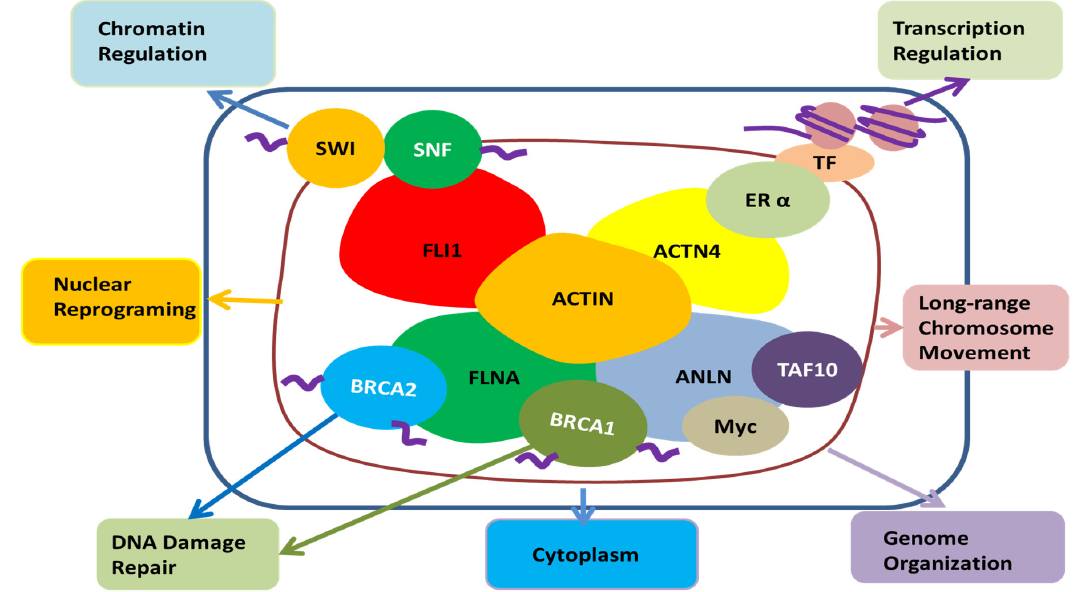
Figure 4. The potential role of ANLN in the nucleus; Actin present in the nucleus is combined with FLi1 homolog, α -actinin 4, filamin A, SWI/SNF, estrogen receptor α , BRCA 1, 2, etc., and it seems to be involved in chromatin remodeling, transcription regulation, nuclear reprogramming, long-range chromosome movement and DNA damage repair. ANLN has the potential to be involved in their action through binding with actin in the nucleus. Moreover, it can be involved in chromatin reorganization, transcription, and DNA damage repair through direct binding with TAF10, Myc, and BRCA1. In addition, it has been reported that ANLN is present in the nucleus to regulate the cell’s movement and infiltration by regulating the signal of the cytoplasm [114]. FLI1, friend leukemia integration 1 transcription factor; SWI/SNF, Switch/Sucrose non-fermentable; FLNA, Filamin A; BRCA1, breast cancer type 1; BRCA2, breast cancer type 2, ANLN, anillin actin-binding protein; Myc, a family of regulator genes and proto-oncogenes that code for transcription factors; TAF10, TATA-Box-binding protein associated factor 10; ACTN4, α -actinin 4; ER α , Estrogen receptor alpha; TF, transcription factor; Actin, a family of globular multi-functional proteins that form microfilaments.